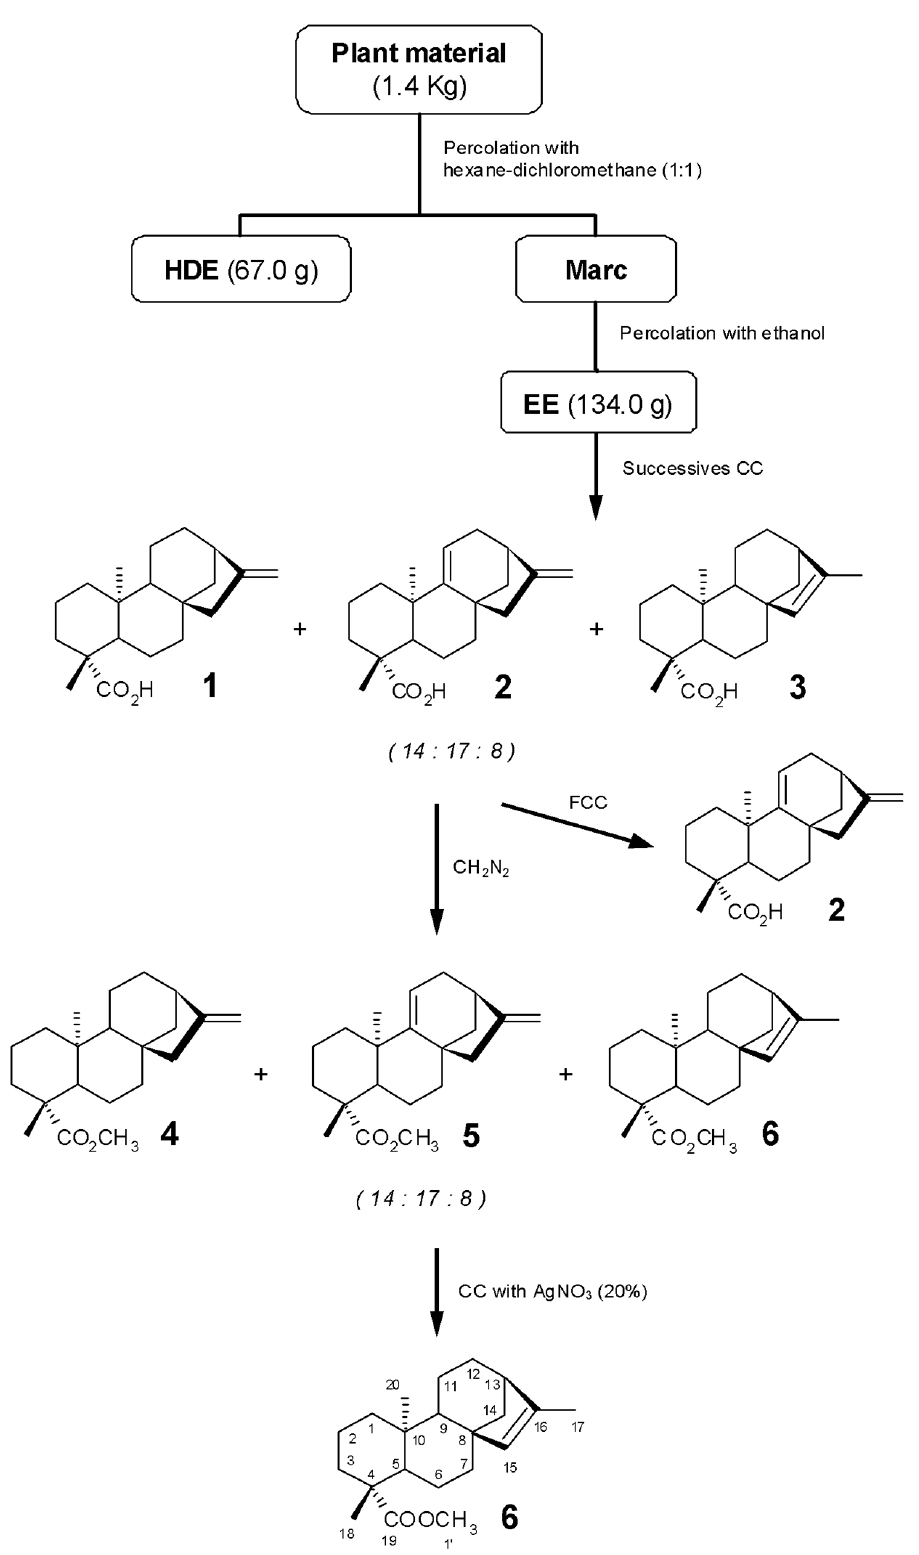
Scheme 1 – Isolation of diterpenes 2 and 6 from W. paludosa